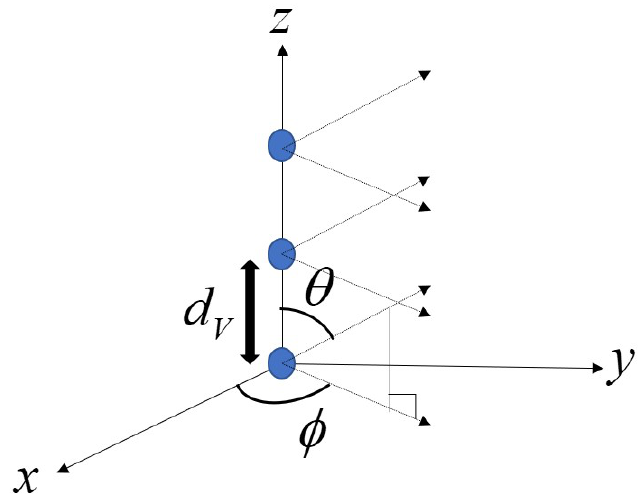
Figure 4. The structure of antenna